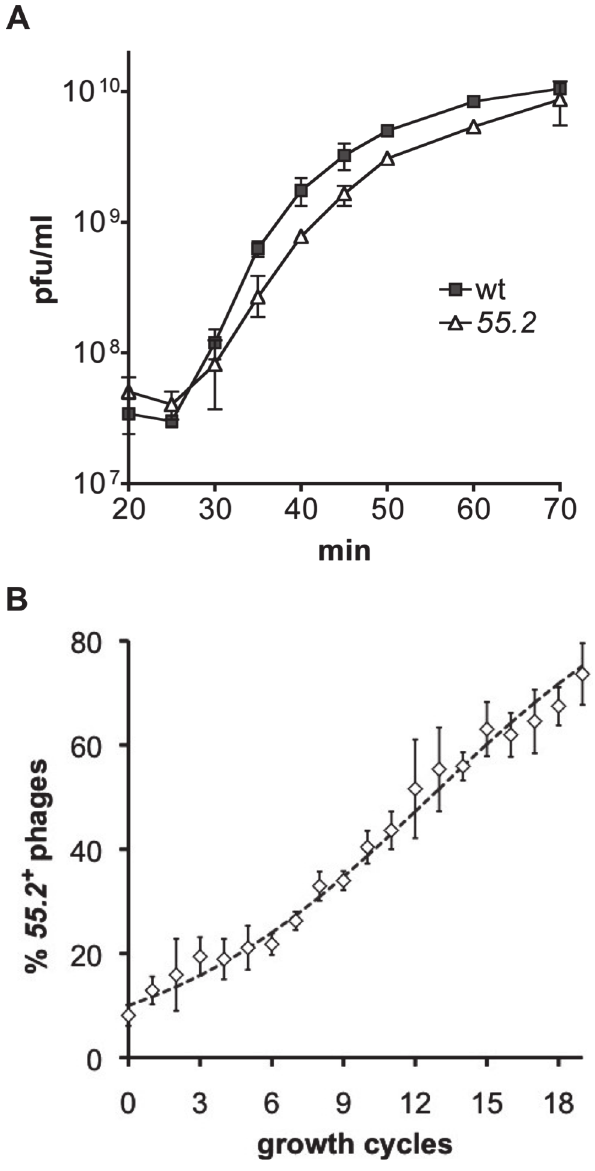
Fig 5. Loss of gene 55 . 2 function reduces T4 phage fitness. (A) CR63 cells grown in M9 medium were infected with T4 K10 (wt) or T4 K10- 55 . 2 ( 55 . 2 ) at a moi of 6 at 30°C. Intracellular phage accumulation was followed at the indicated time points; free phages at 25 min represented < 12% of the total infective centers. Data represents mean and ranges of two (wt) and four ( 55 . 2 ) independent experiments. (B) Competition experiment. A mix of T4 K10 and T4 K10- 55 . 2 with an initial ratio of 1:9 was grown on E . coli CR63 in M9S medium at 37°C at low moi ( < 0.1) over successive growth cycles. The percentage of 55 . 2+ phages was determined by PCR and digestion as described in Materials and Methods. Data represent mean and standard deviation of four independent experiments; the dotted line represents the result of a simulation were the 55 . 2 mutant has a 16% disadvantage per growth cycle. The intracellular phage accumulation over a single growth cycle in these conditions is shown in S5A Fig.